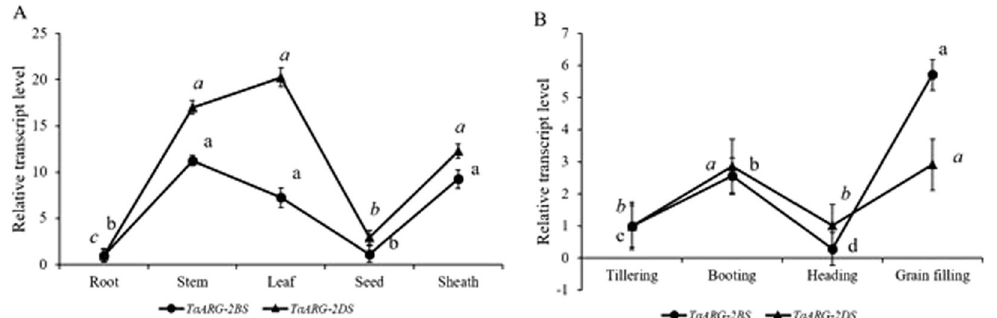
Figure 6. Transcript levels of two TaARG genes in different wheat tissues and developmental stages determined by qRT–PCR. ( A ) Different tissues; ( B ) Different developmental stages; Each data point is an average of three biological repeats (mean ± SD). Small letters in bold or italic represent significant differences between TaARG- 2BS and TaARG-2DS at α < 0.05 using Duncan’s multiple range